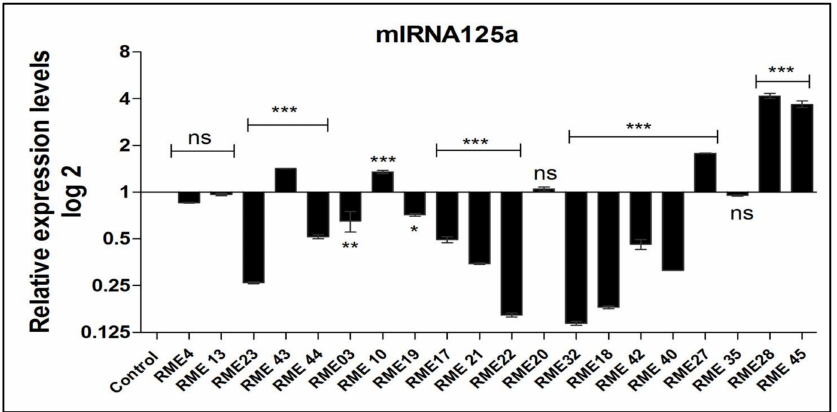
Figure 4. Representative figure for the relative expression analysis of miR-125a (*** cases represents highly significant, ** significant and * less significant. ns represents non- significant).